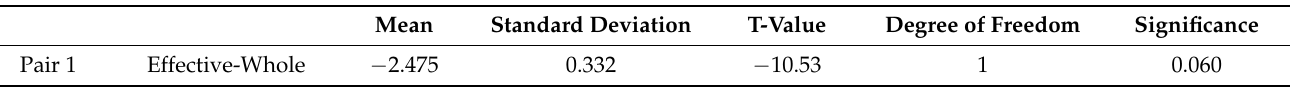
Table 8. T-test of the difference of the total correct classification rate (CCR) of the MV classifier using all the spectral data and using only the most effective wavelengths in